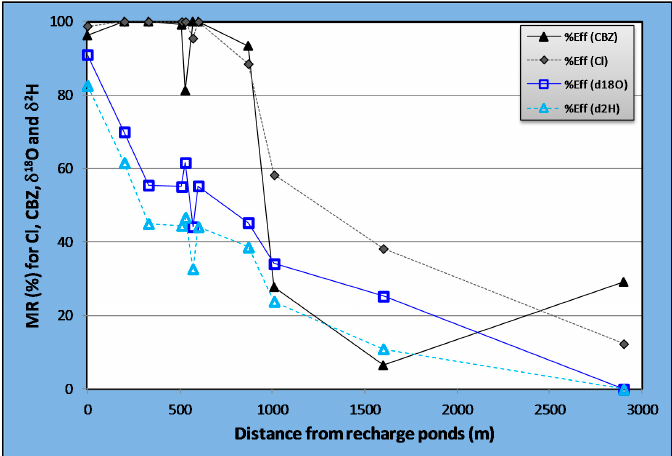
Figure 5. Mixing ratios (MR) in recovery and observation wells vs. distance from the recharge ponds. MRs were calculated from Cl, CBZ, δ 18 O and δ 2 H results of the 2010–2011 campaign.